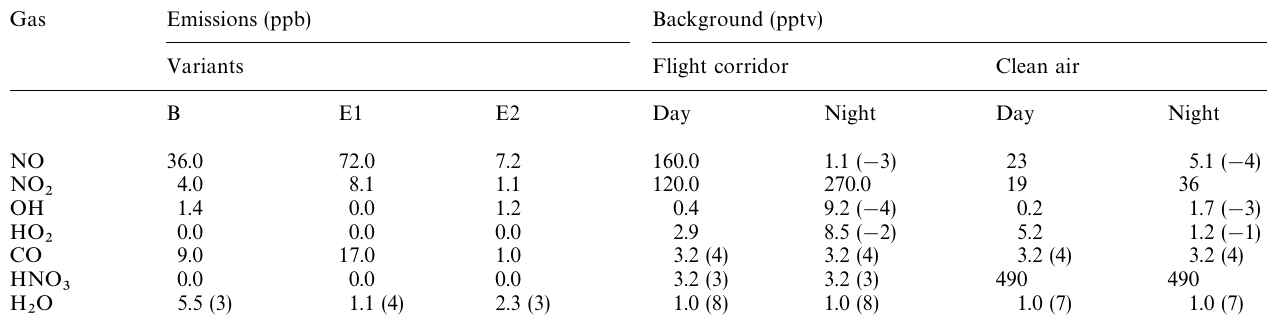
Table 1. Initial mixing ratios of aircraft emitted gases and their background values at the 10 km level for the calculated variants ( a ( b ) " a 10 (cid:34) )